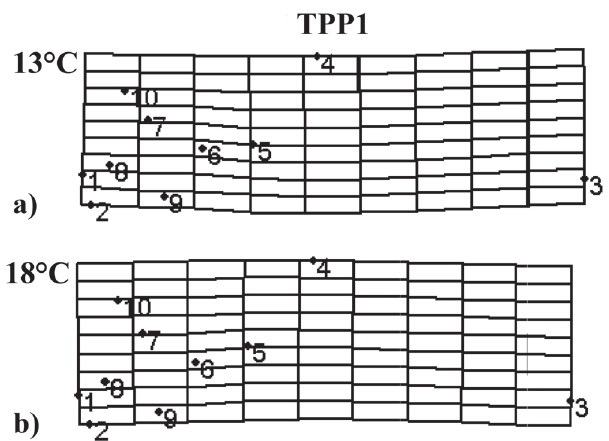
Fig. 6. Box plots for linear measurements of newly hatched free embryos incubated at 18ºC: a ) first discriminant function (Function 1), b ) residuals yolk sac width, and c ) residuals yolk sac length, all versus age at